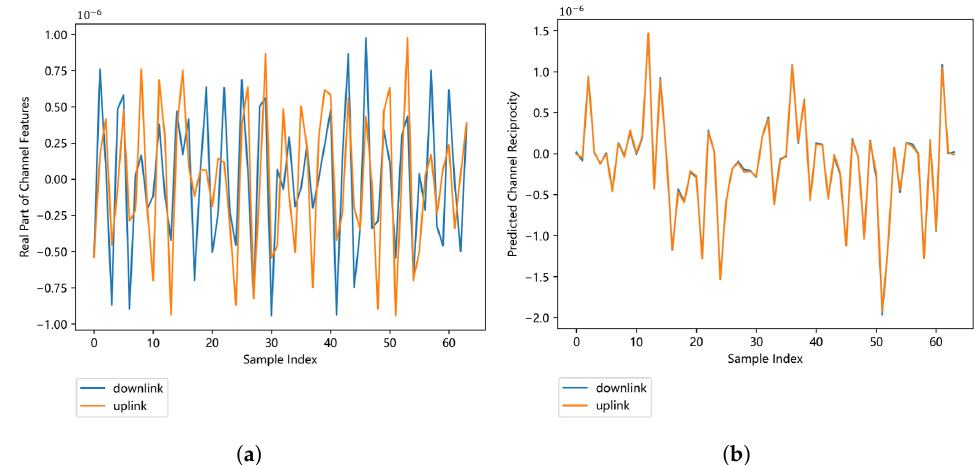
Figure 8. Comparison between the original channel features and the predicted channel features. ( a ) Channel response that contains reciprocal and nonreciprocal components. ( b ) Channel response that mostly contains predicted reciprocity extracted by IRS-CRNet.